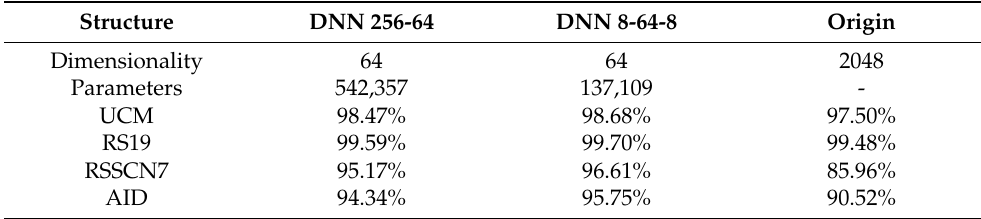
Table 2. Comparison of the impact of feature transform network structure on